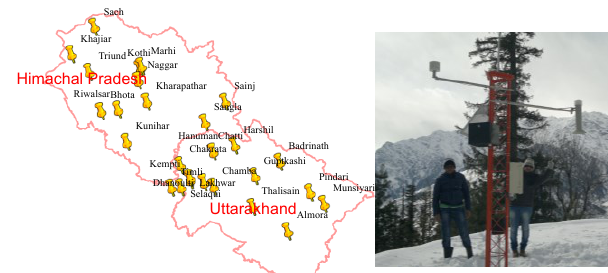
Figure 2. Location of installed IIRS-ISRO AWS network in HP & UK with filed picture of Kothi AWS with snow depth sensor.